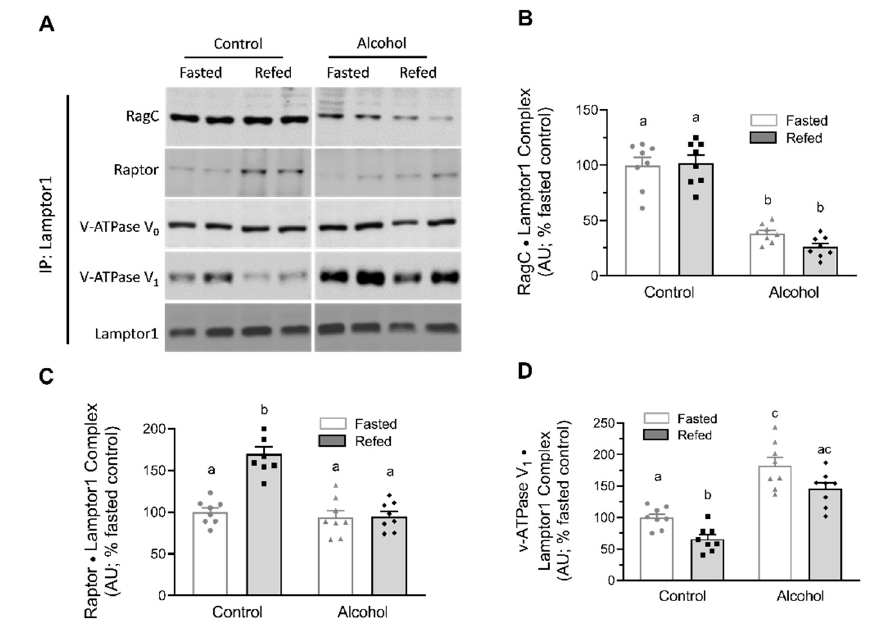
Figure 6. Alterations in LAMPTOR1 protein complexes after refeeding in muscles from control and alcohol-receiving mice. LAMPTOR1 was immunoprecipitated (IP) and immunoblotting was performed for RagC, Raptor and v-ATPase V 1 . ( A ) presents representative Western blots for these complexes. Although samples from all groups were loaded on the same gel, a gel break depicts lane(s) of the gel that have been deleted. Data from all tissues are quantitated in bar graphs ( B – D ). Bar graphs represent analyses for all immunoblots, where the mean of the fasted saline-treated control group was arbitrarily set at 100 AU. Values are mean ± SEM with n = 8/group. Only values having different superscript letters are statistically ( p < 0.05) different .